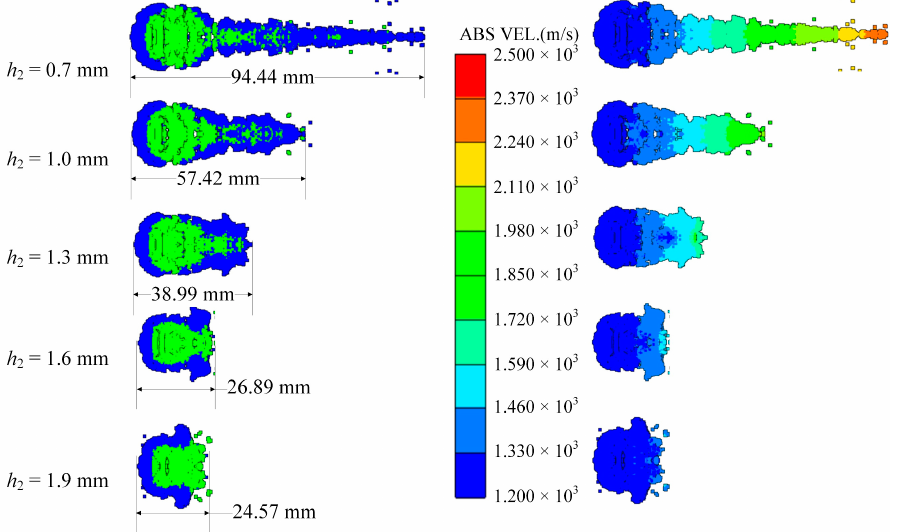
Figure 10. Coating shapes and velocity distribution as the edge thickness of the copper liner changes.